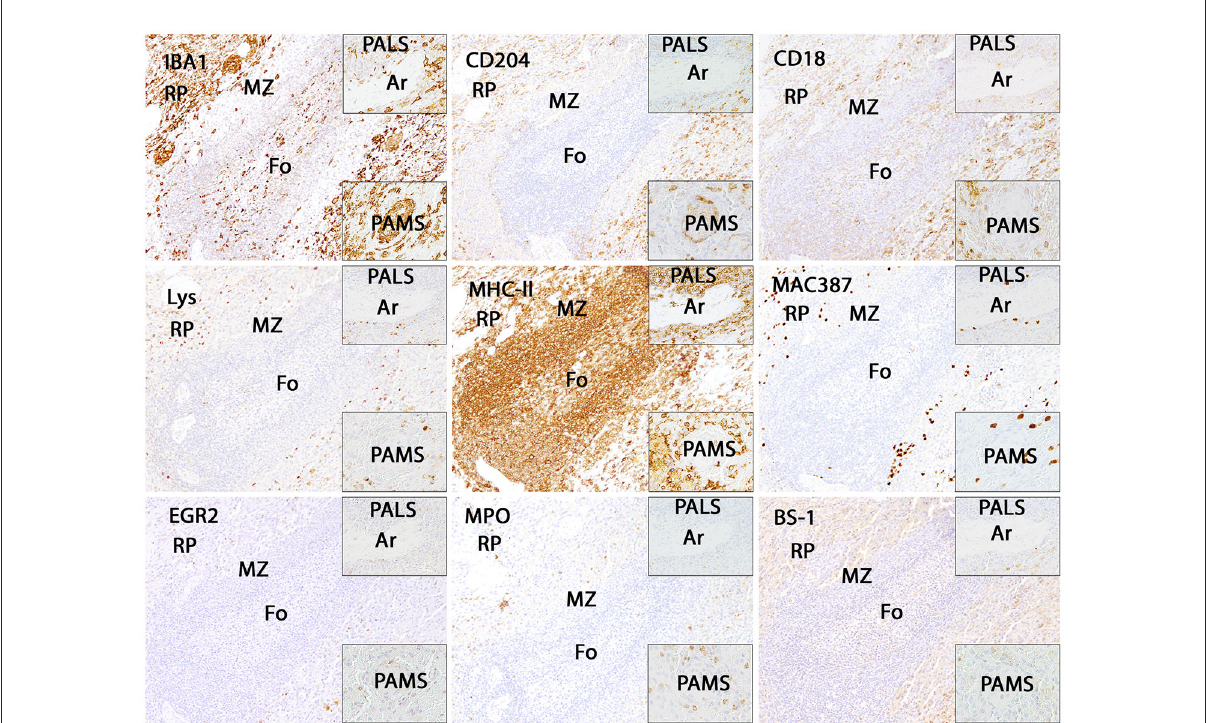
FIGURE6 Illustration of IBA1, CD204, CD18, lysozyme (Lys), MHC-II, MAC387, EGR2, myeloperoxidase (MPO) and BS-1 immunostaining in the canine spleen. The white pulp including follicles (Fo), marginal zone (MZ) and periarteriolar lymphocytic sheath (PALS; upper insert) is characterized by intense expression of MHC-II, whereas all other markers are expressed by only few cells. Within the periarteriolar macrophage sheath (PAMS; lower insert) numerous cells are positive for IBA1 and CD204. The red pulp contains moderate to high numbers of IBA1-, CD204-, CD18- and MHC-II-positive cells. Immunohistochemistry using the avidin-biotin complex immunoperoxidase method. Ar: